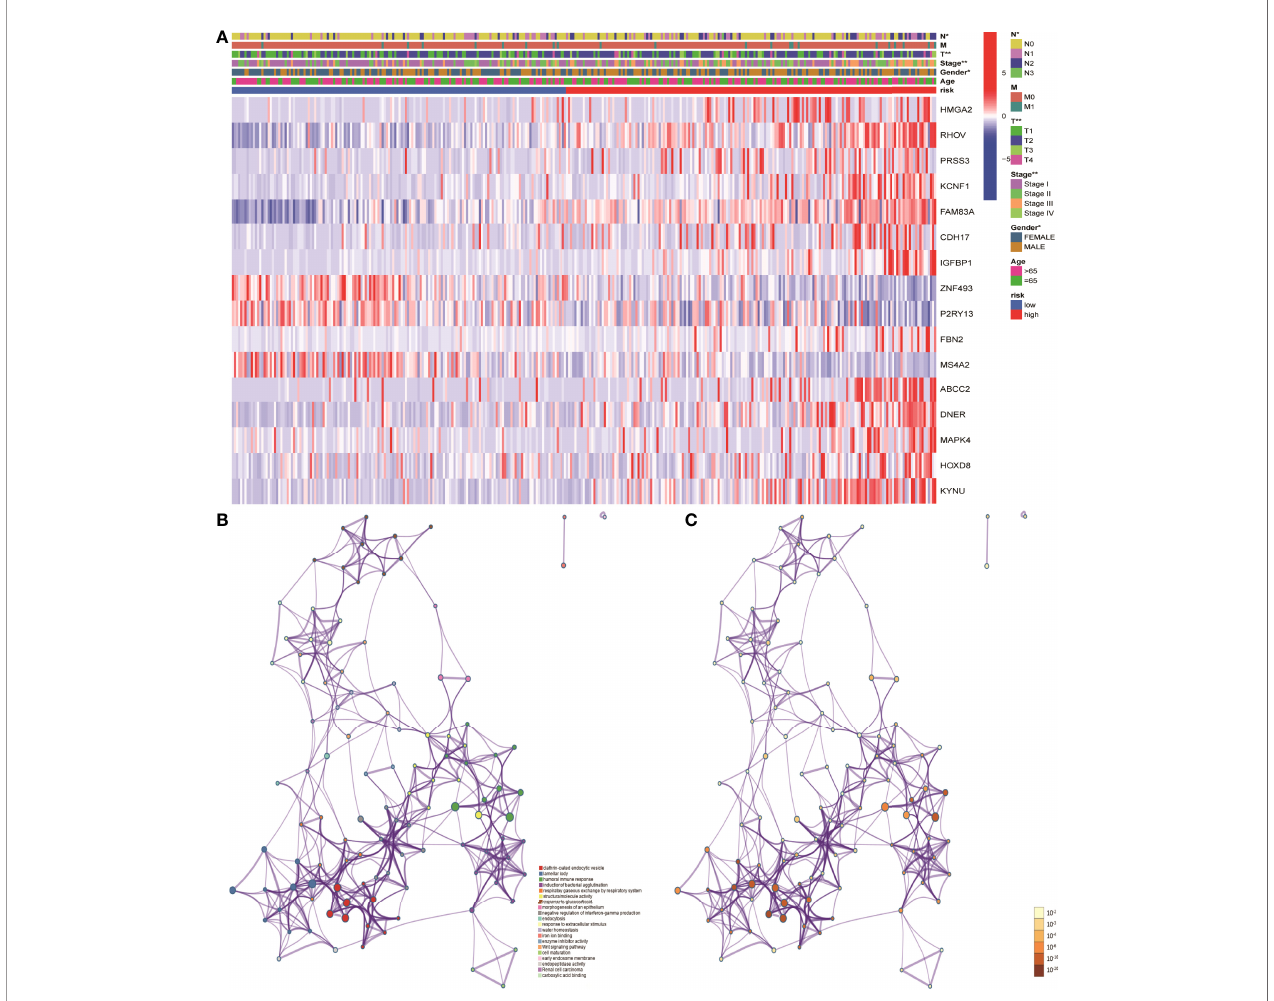
FIGURE 6 | Mechanistic analysis of the involvement of risk scores in tumor occurrence and development. (A) Clinical manifestations such as clinical stage, gender and TN stages showed signi fi cant differences between the high- and low- risk groups. (B, C) GO and KEGG functional analysis showed that the risk scores in tumor development play a role through biological functions such as humoral immune response and pathways such as Wnt signaling